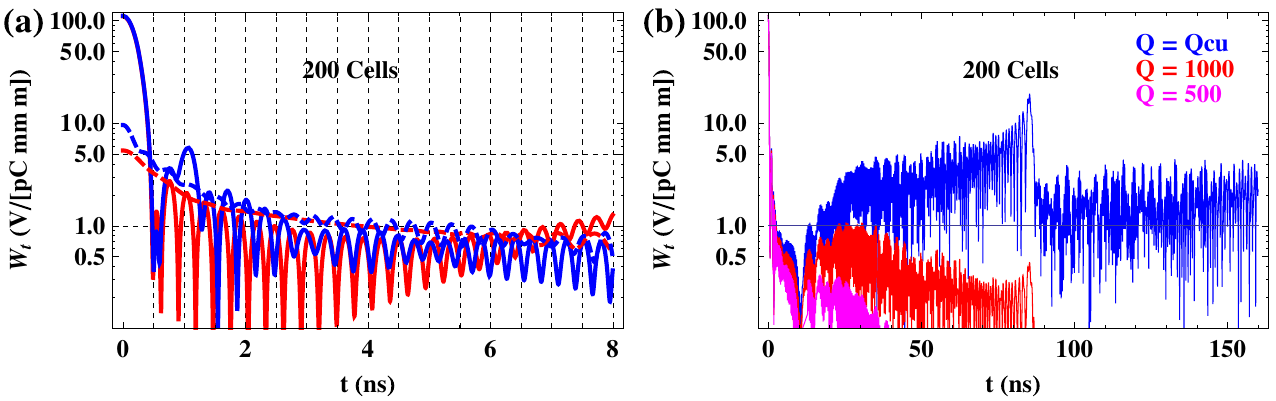
FIG. 14. (Color) Envelope of wakefield based on moderate damping and detuning for CLIC. Eightfold interleaving of a 25-cell structure results in 200 equivalent cells. The wakefield (excluding Ohmic losses) for the first 16 bunches is shown in (a) using an uncoupled model (in blue) and a coupled model (in red). Also shown in (b) is the wake for all subsequent bunches with various Q